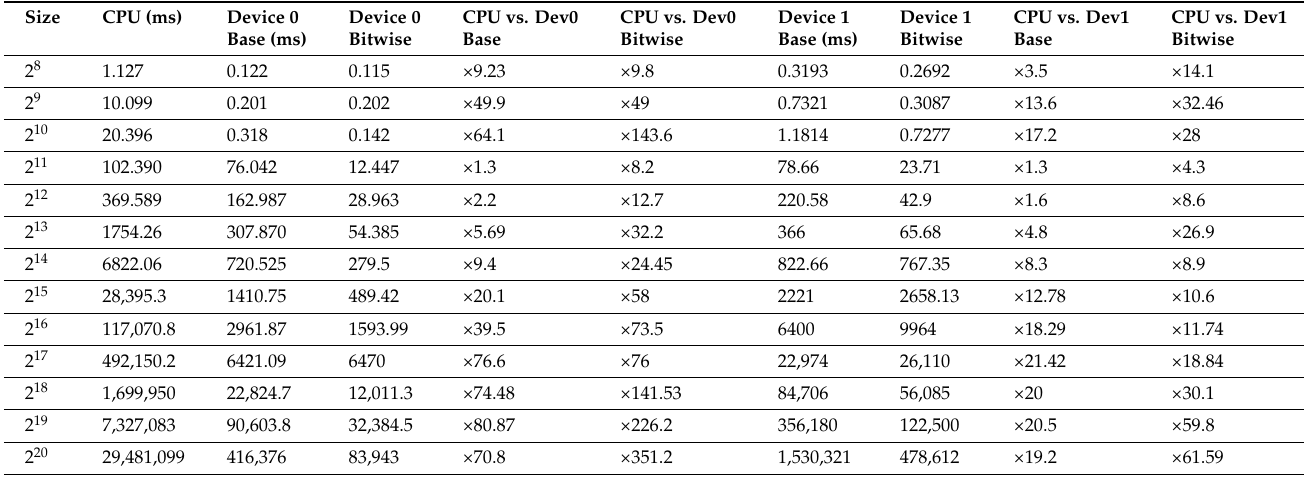
Table 5. Computing degree— deg ( S ) –deg_ bitwise